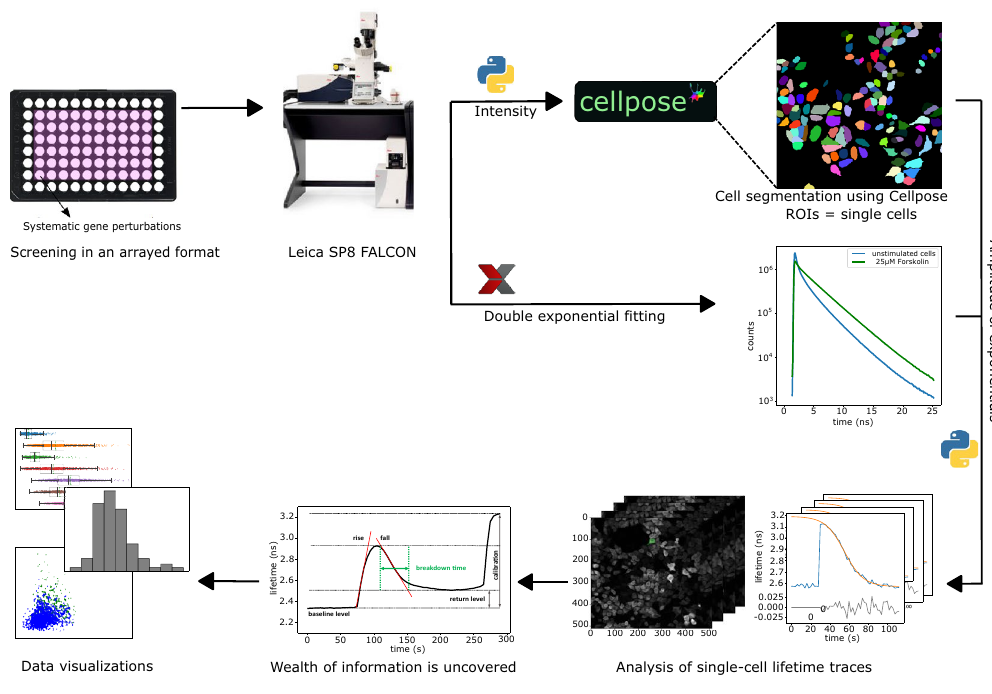
Figure 2. Schematic overview of the FLIM screen for dynamic changes in cAMP. HeLa cells expressing FRET- FLIM sensors grown in 96-well plates are treated with siRNA pools for 48 h. Fluorescence was read out using an automated Leica SP8-FALCON FLIM microscope. The time-average of fluorescence intensity was used for segmentation using Cellpose, whereas the fluorescence lifetime data were fitted with a double-exponential decay using fixed fast and slow components of 0.6 ns and 3.4 ns, respectively. The magnitudes of those two components were exported to Python for further analysis. Based on the segmented ROIs, lifetime data were plotted for each individual cell, subjected to quality control, and agonist-induced changes were fitted with a suitable model. The fitting parameters are then summarized in descriptive